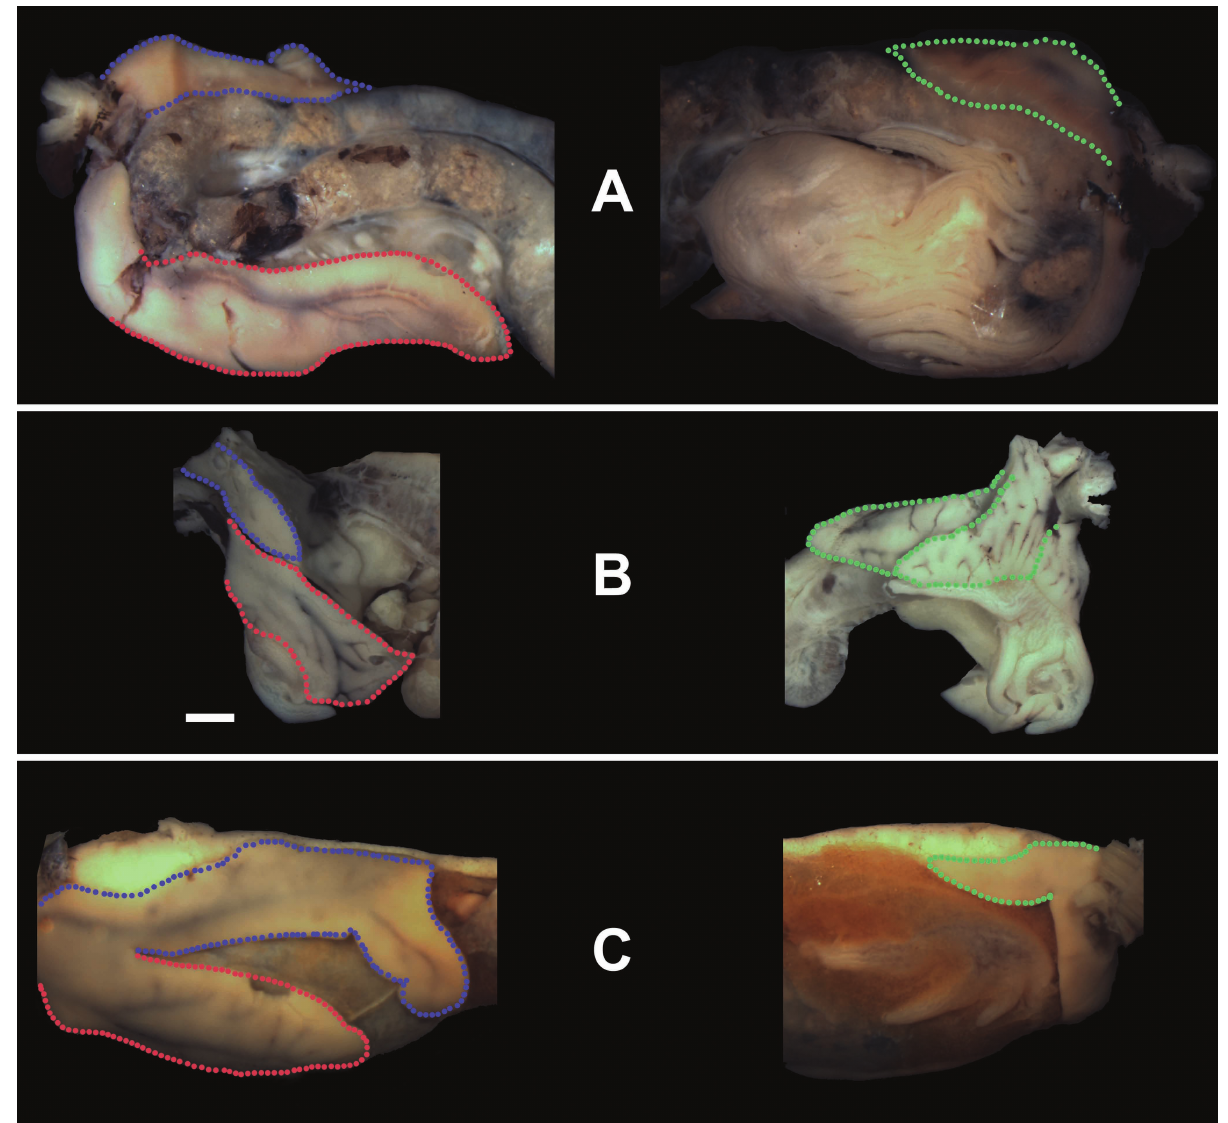
Fig. 4. Liver lobes of selected species of Characidae. Lateral view anterior to left at the left side of the figure. Anterior to right at the right side of the figure. Proposed primary homologue lobes are delimited by the same color. Light blue bar indicates approximately position of anterior distal margin of gas bladder posterior chamber. A - Astyanax endy ; B - Gymnocorymbus ternetzi ; C - Characidium borellii .